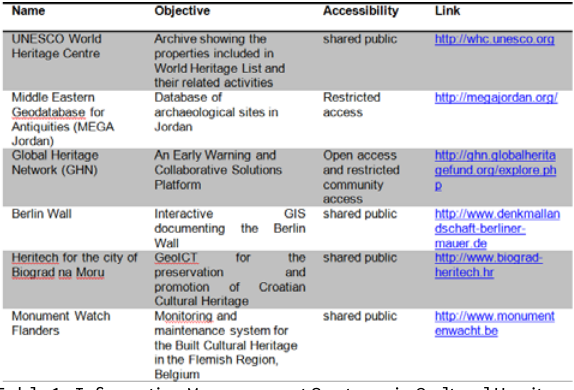
Table 1: Information Management Systems in Cultural